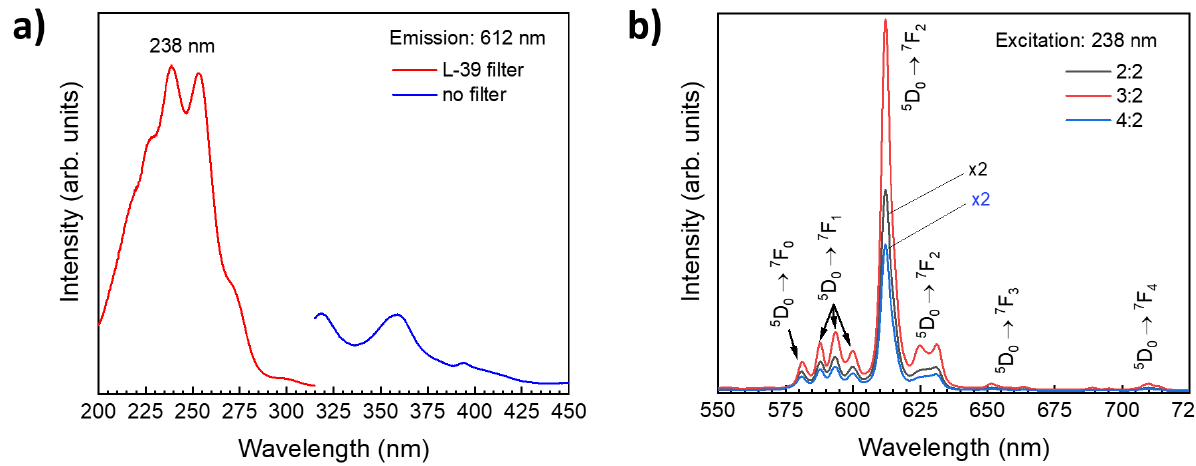
Figure 2. ( a ) Excitation spectra and ( b ) emission spectra of ALD Y 2 O 3 :Eu thin films prepared with different Eu concentrations. The measurements were performed at room temperature.